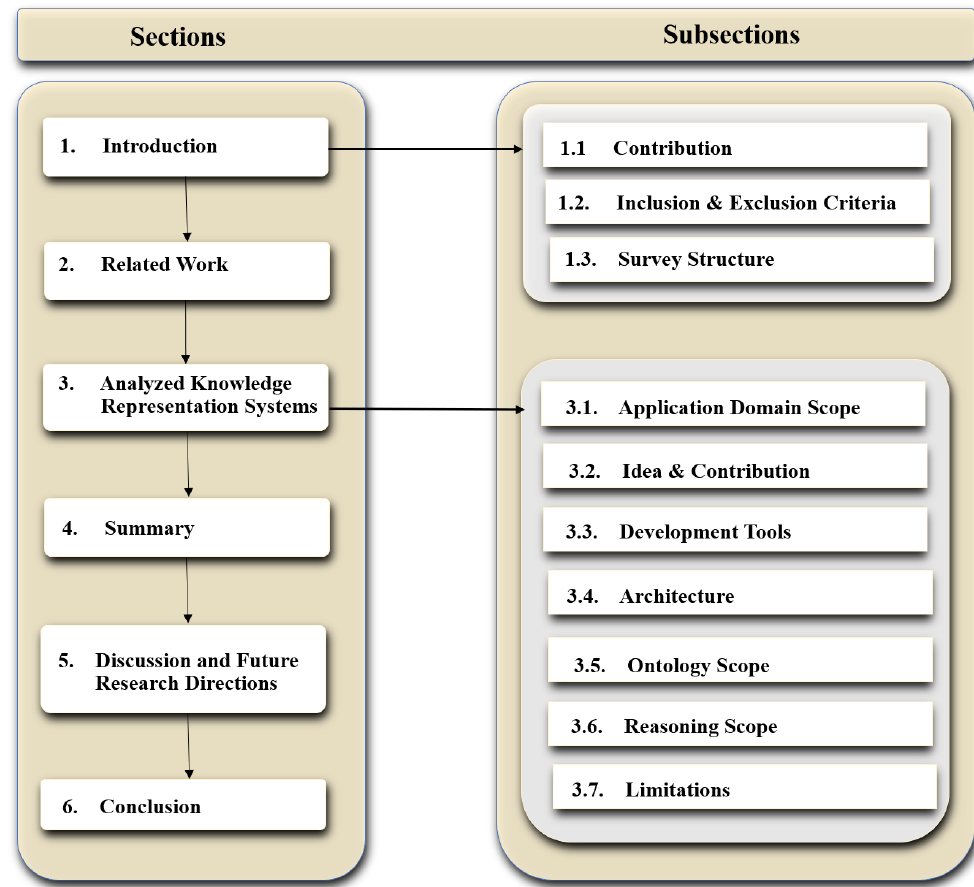
Figure 3. Survey structure and its corresponding